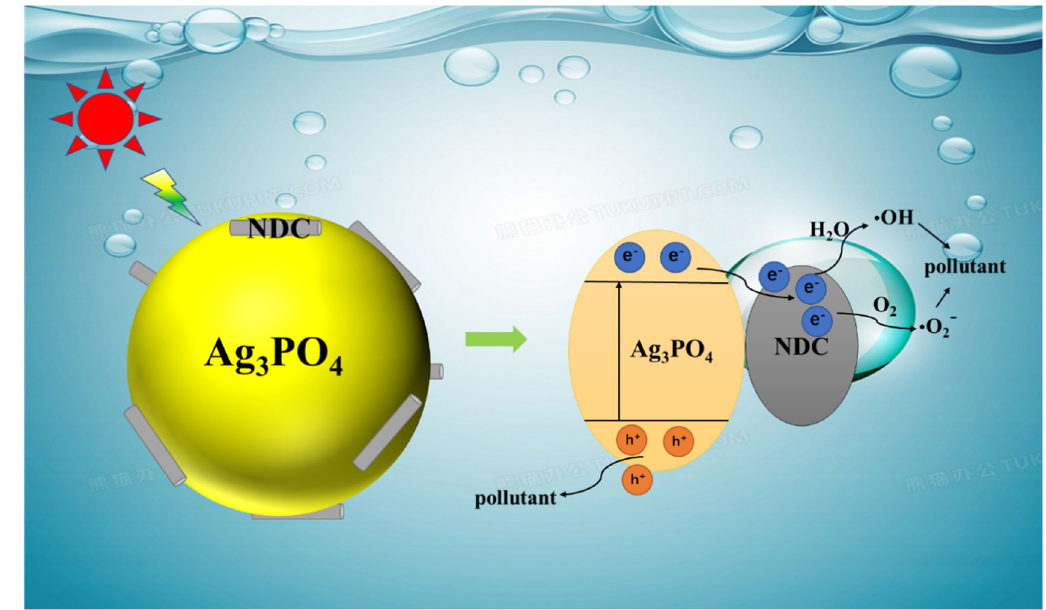
Figure 10. Degradation mechanism of Ag 3 PO 4 @NDC composite photocatalyst.